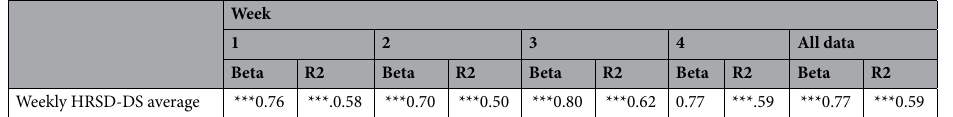
Table 3. Correlations between one-week average of HRSD-DS scores and weekly HRSD score across the four weeks of study. ** p < 0.01, *** p < 0.001. Beta coefficient (standardized) and r square from linear regression predicting HRSD by